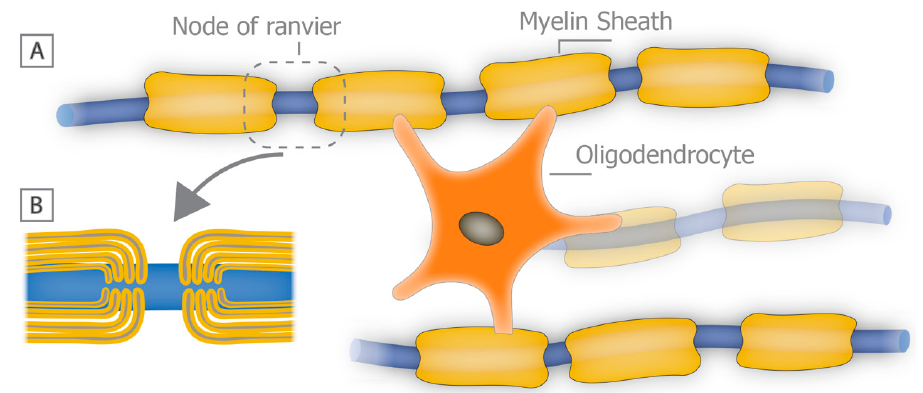
Figure 1. Structure of the myelin sheath in the central nervous system (CNS). ( A ) schematic diagram depicting a mature oligodendrocyte contributing to the myelin sheaths of three individual axons.